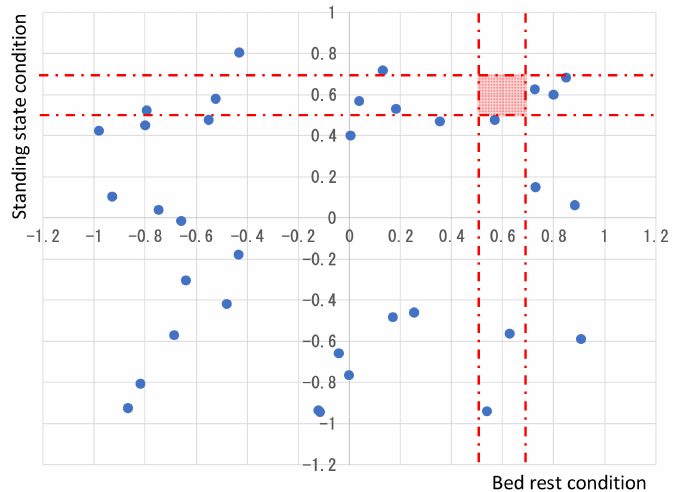
Figure 5. Possibility of OD determined by obtaining Fisher’s correlation coefficient of the bed rest-standing state using a positioning